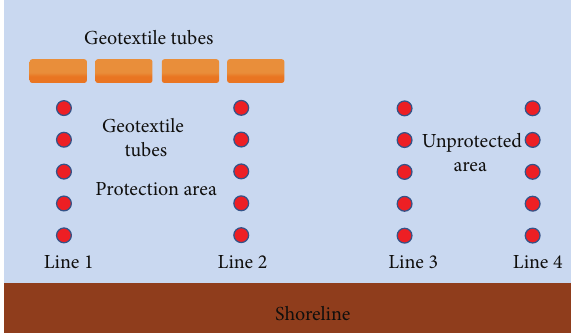
Figure 5: Location of measuring pins behind the geotextile